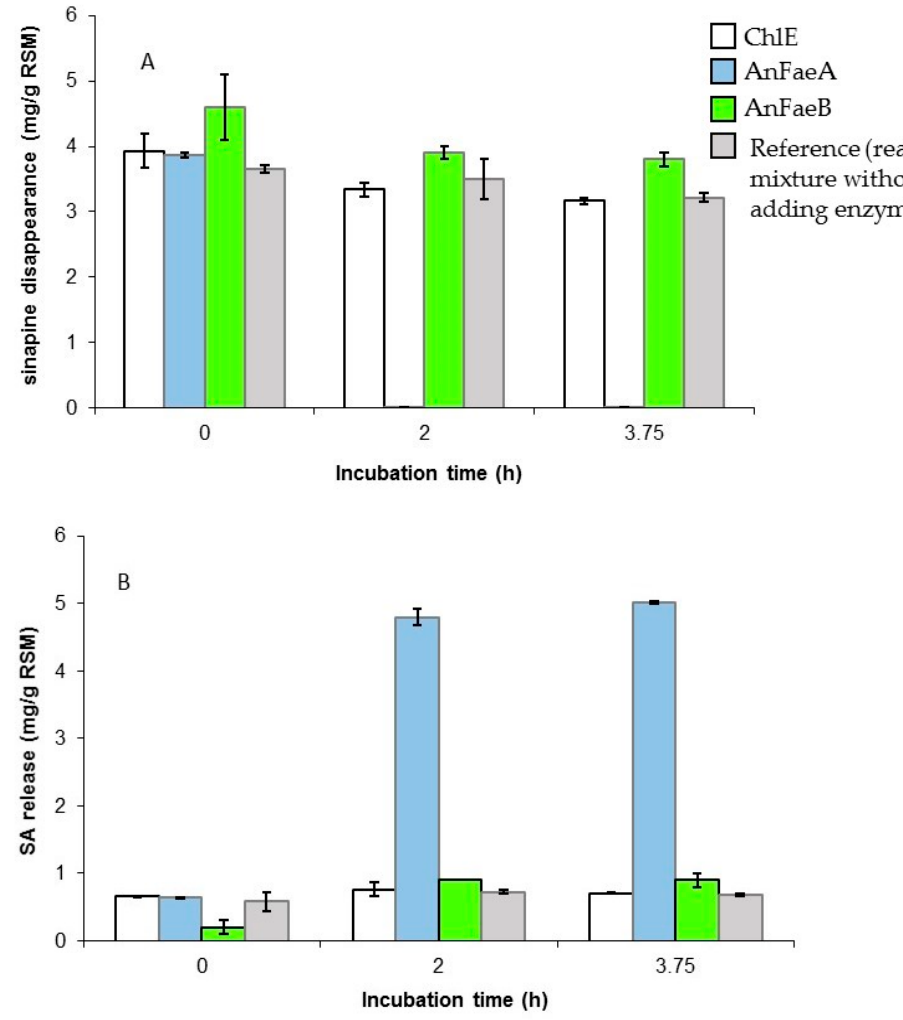
Figure 2. Time course of sinapine disappearance ( A ) and SA increase ( B ) in the reaction mixture of RSM hydrolysis as a function of the cinnamoyl esterase tested.